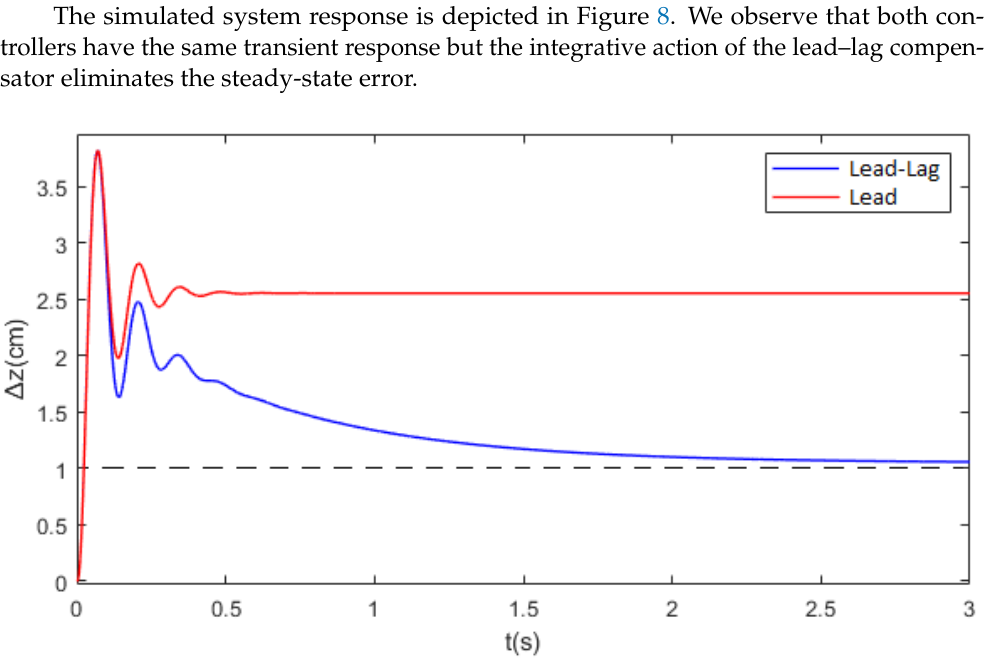
Figure 8. Response to step input of the linearized system with both classic controllers.